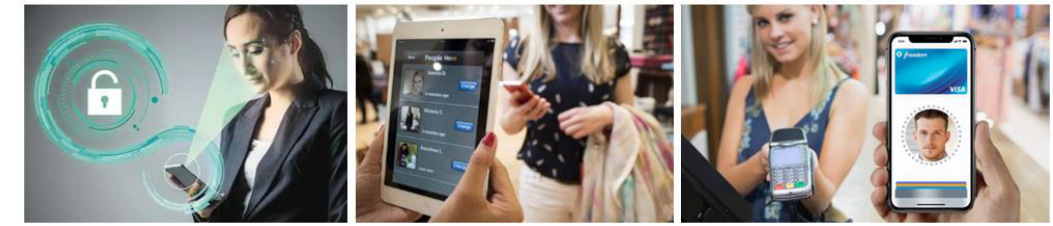
Figure 46. Examples of face recognition applications using smartphones.